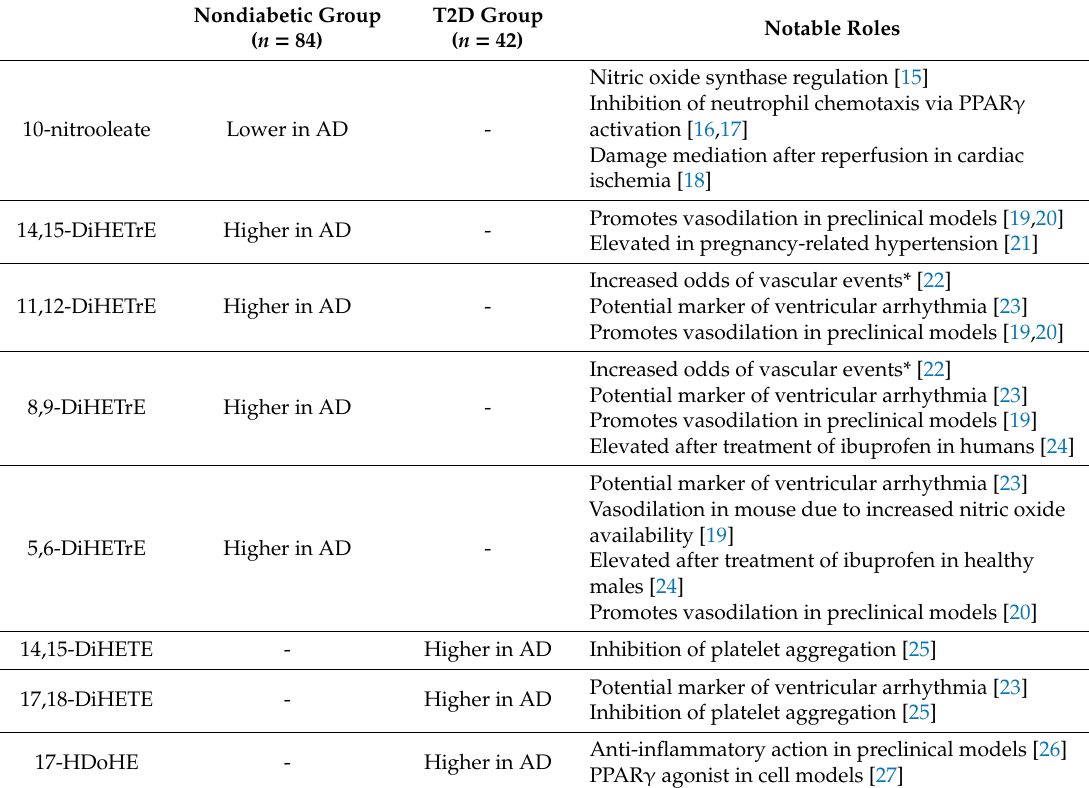
Table 3. Directionality of e ff ects within metabolic groups as identified via nonparametric